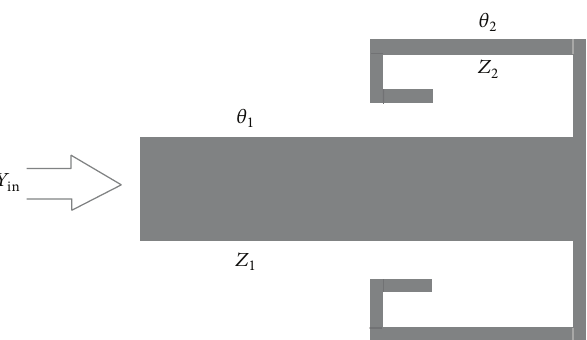
Figure 21: Structure and schematic diagram of the new proposed structure for SIR resonators, in which the second section of the SIR is replaced with a two branch-line